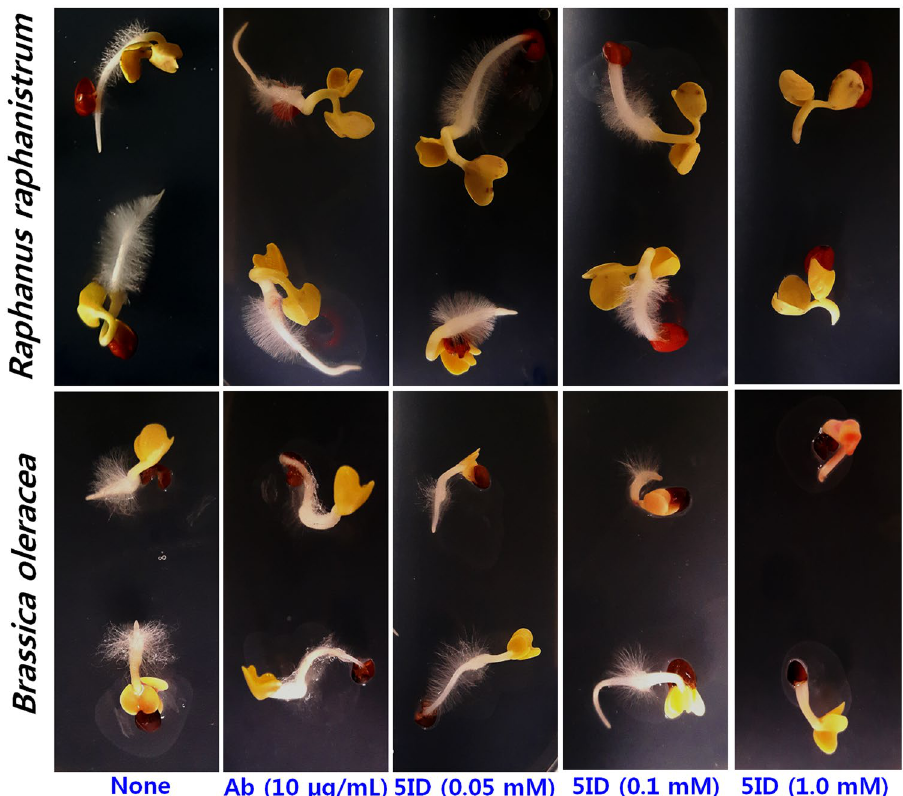
Figure 7. Effect of 5-iodoindole on seed germination. B . oleracea and R . raphanistrum seeds on Murashige and Skoog agar medium supplemented with or without abamectin or 5-iodoindole, showing sprouting, germination, and lateral roots. Germination was recorded after incubation for 3 days at 22